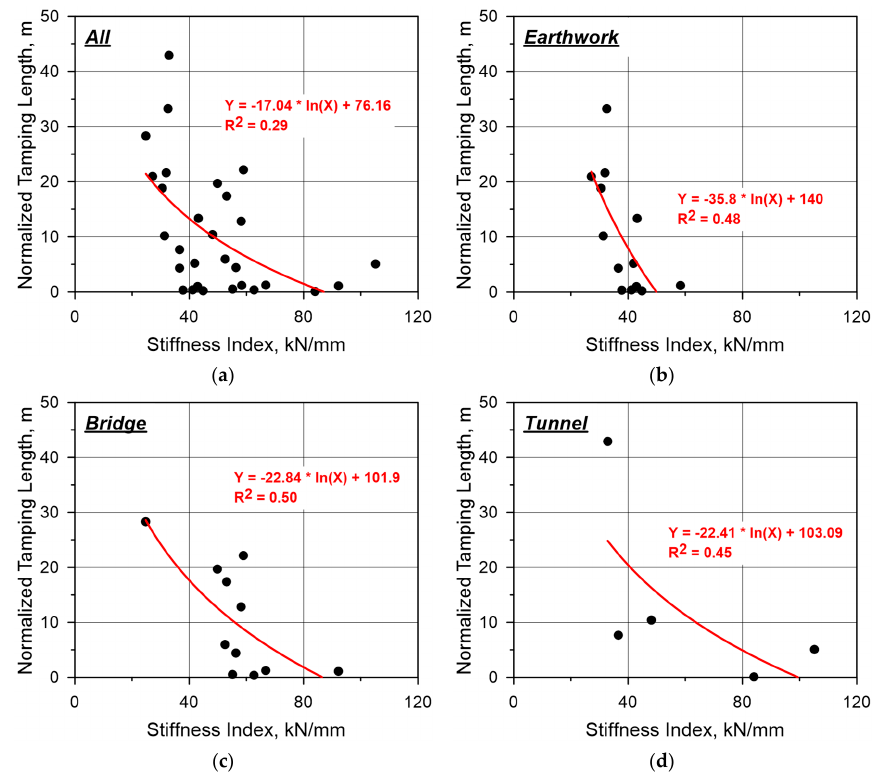
Figure 9. Track stiffness index ( α = 0.6) versus cumulative tamping length: ( a ) All; ( b ) Earthwork; ( c ) Bridge; ( d ) Tunnel.